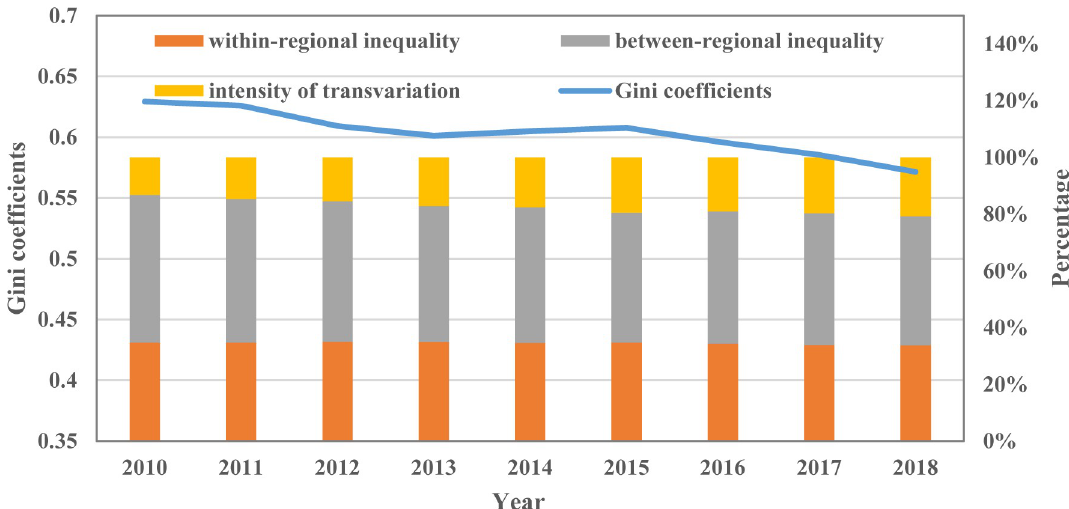
Fig 7. The spatial difference in total carbon emissions from civil